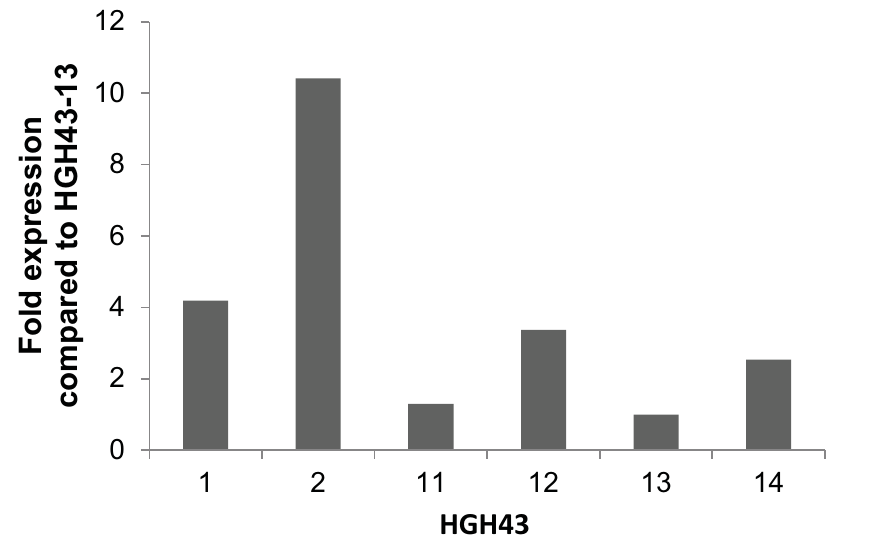
Fig 2. Expression of hgh43 in A . bisporus transformants relative to transformant HGH43-13.